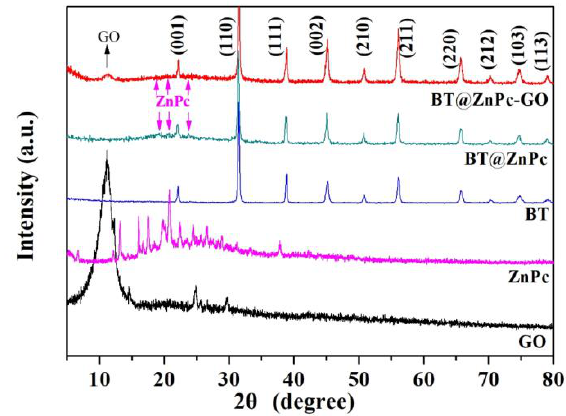
Figure 5. X-ray diffraction (XRD) patterns of GO, ZnPc, BT, BT@ZnPc and BT@ZnPc-GO.